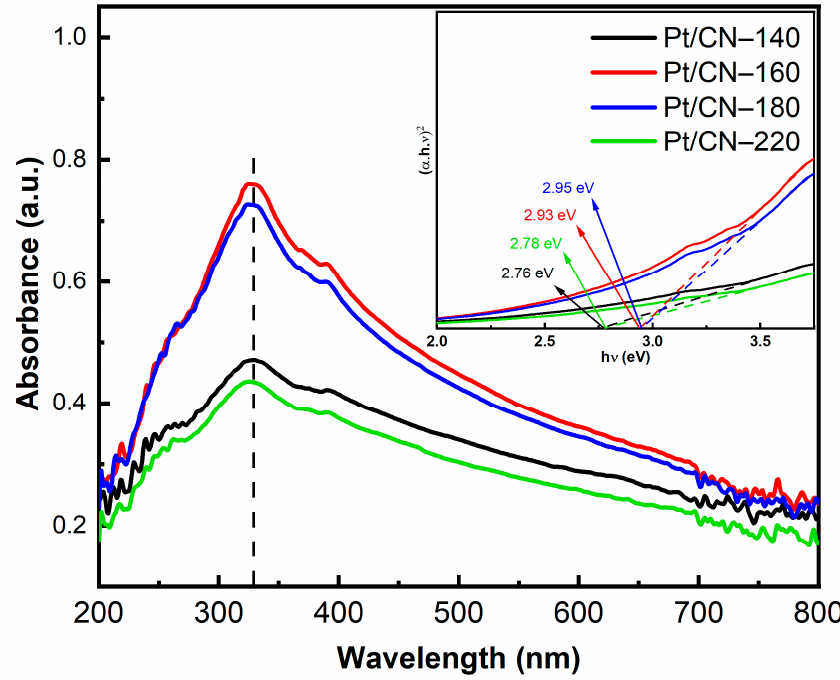
Figure 6. The UV–Vis spectra of the Pt/CN photocatalysts (inset: the corresponding Tauc plots).